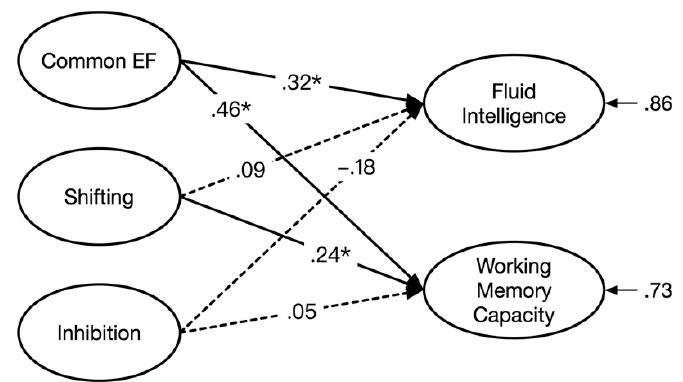
Figure 4. The prediction of fluid intelligence and working memory capacity with three latent factors underlying the star counting task including common EF, shifting, and inhibition as predictors (* p < .05).